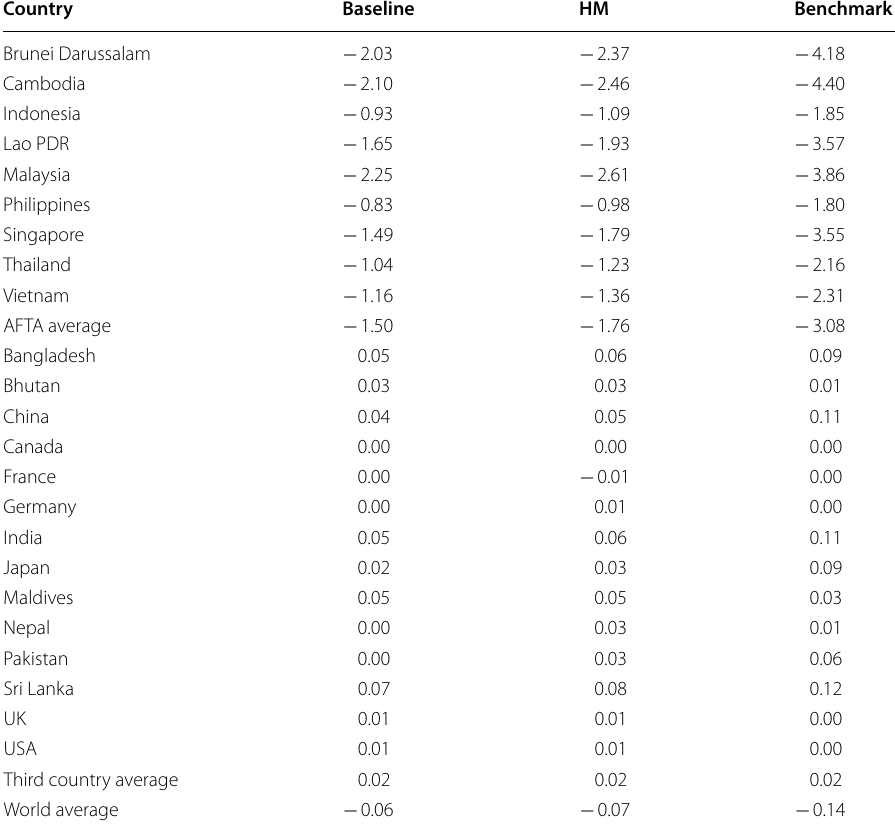
Table 4 Full GE effect of AFTA, measures from the changes in real GDP. Source Authors’